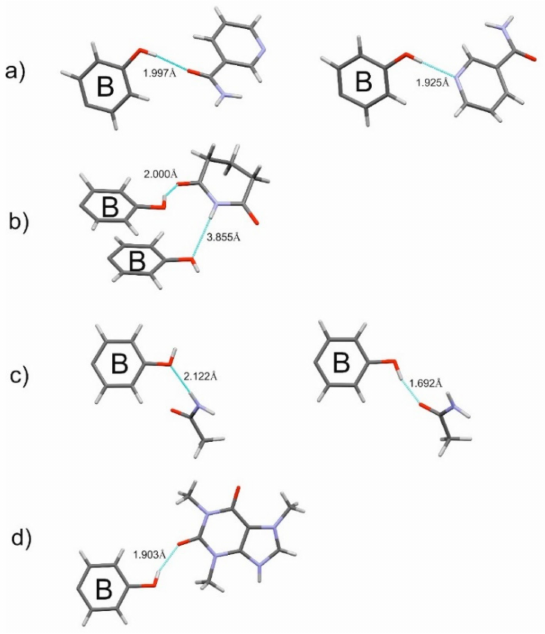
Figure 5. Supramolecular motifs observed in ( a ) XN − NIC, ( b ) XN − GA, ( c ) XN − AC, and ( d ) XN −